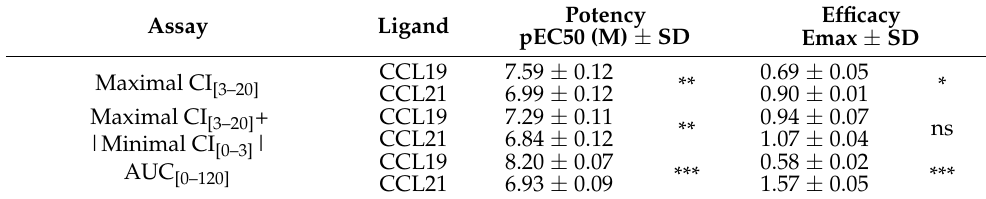
Table 1. Overview of the potency and efficacy of CCR7 ligands in label-free cellular electrical impedance assay. Data are representative of the mean and SD of three independent experiments with two technical replicates. The difference between EC50 and Emax was analysed using an unpaired t-test with Welch’s correction. *, **, and *** represent p < 0.05, 0.01 and 0.001, respectively. ns indicates no significant difference was